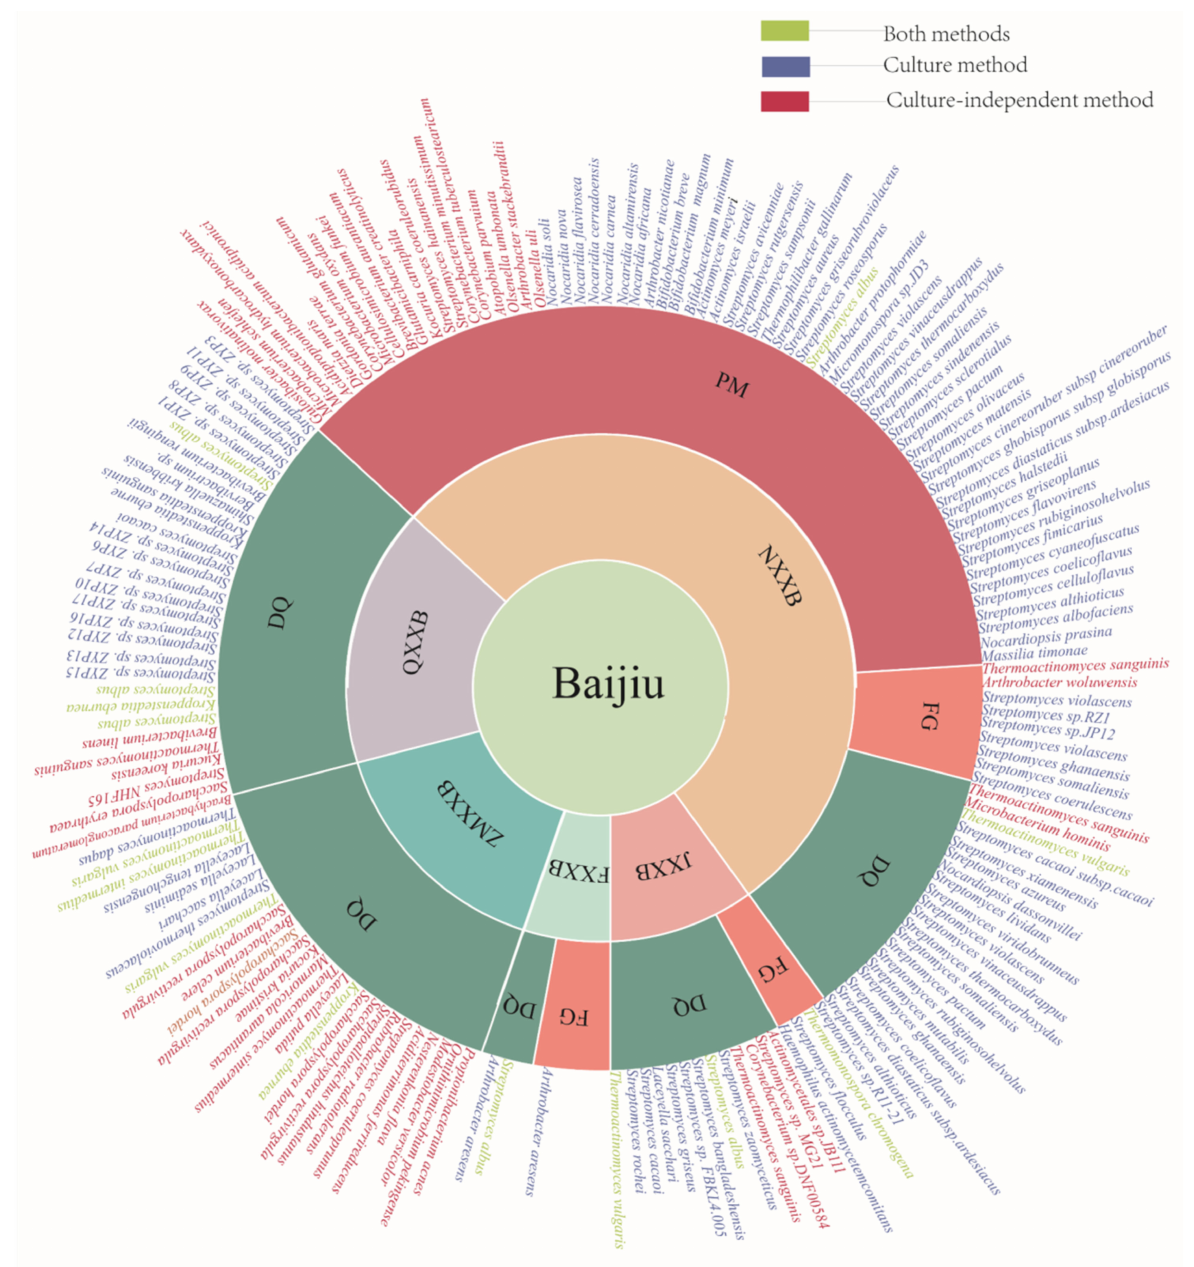
Figure 1. Actinomycete species distribution in the DQ (Daqu), FGs (fermented grains), and PM (pit mud) from different types of Baijiu—jiangxiangxing (JXXB), nongxiangxing (NXXB), qingxiangxing (QXXB), zhimaxiangxingbaijiu (ZMXXB), and andmixiangxing